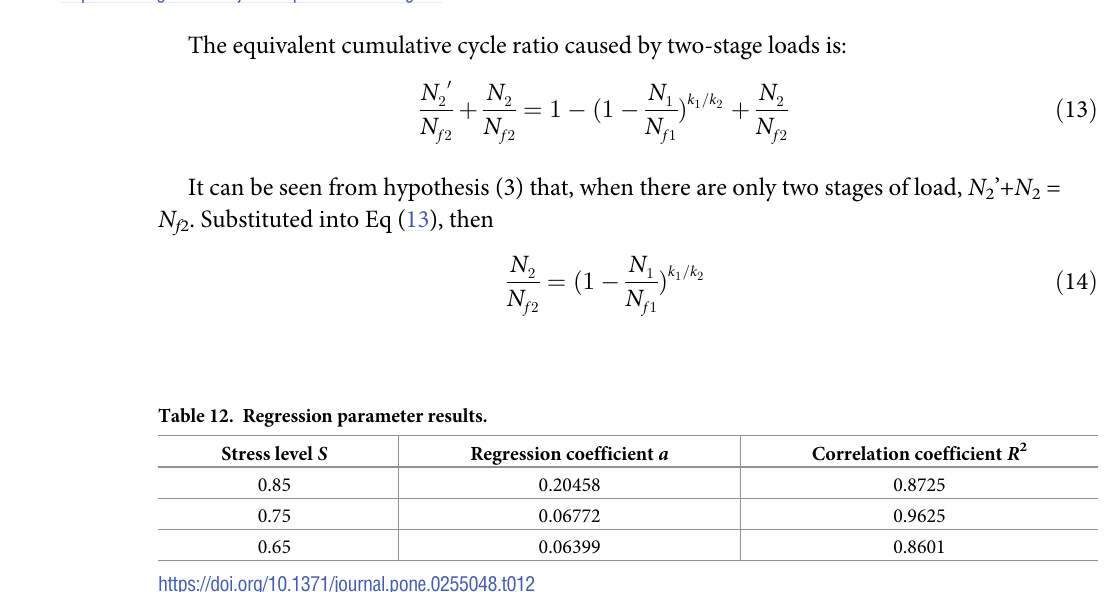
Fig 8. Fitting curve of strength relative damage at different stress levels. (a) S = 0.85. (b) S = 0.75. (c) S = 0.65.